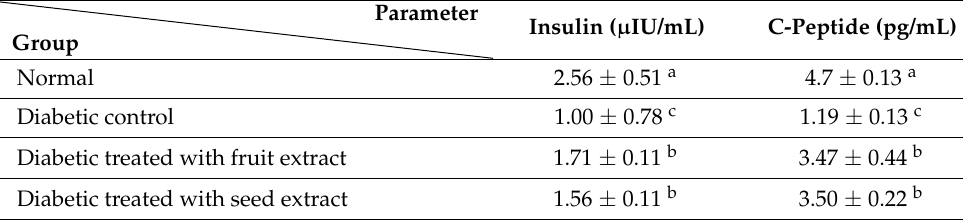
Table 3. Effects of the B . aegyptiaca fruit and seed extracts on the serum insulin and C-peptide levels in NA/STZ-induced diabetic rats.